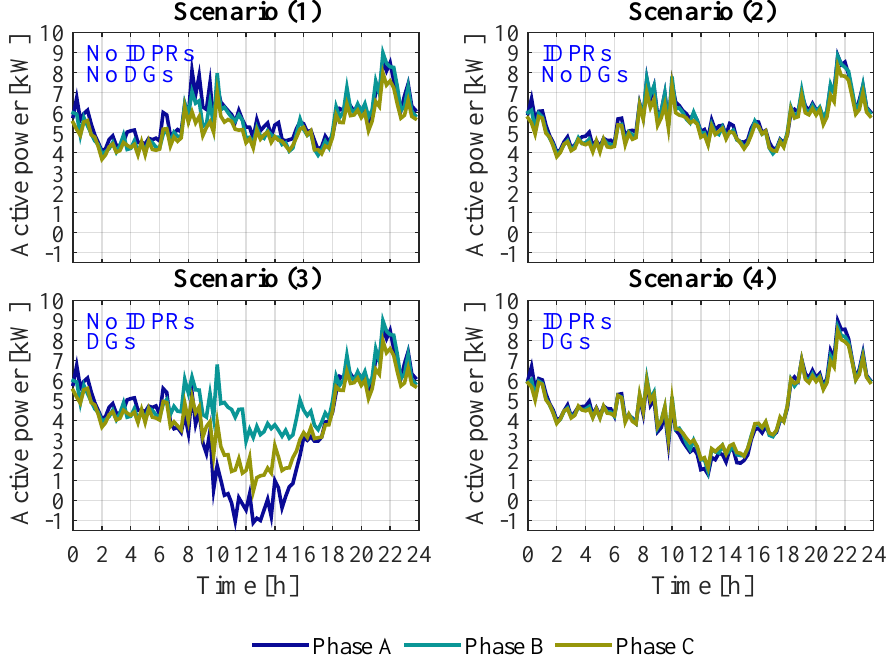
Figure 12. Net active power exchanged per phase with the external grid by the PN with and without including Intelligent Distribution Power Router